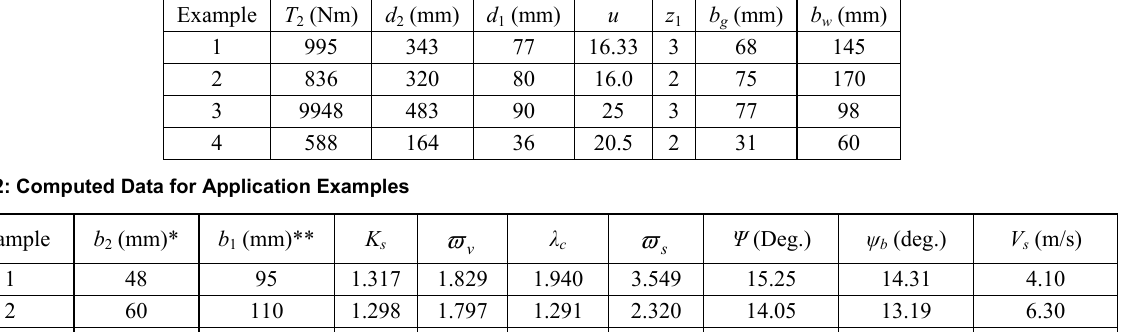
Table 1: Input Data for Application Examples Example